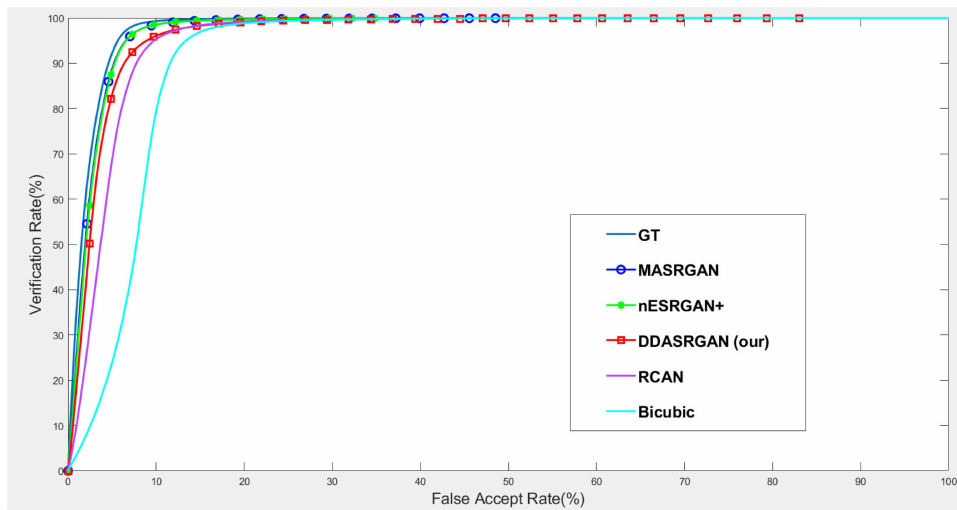
Figure 14. Comparison of ROC curves for each SR model on the CelebA dataset. The figure shows the various SR methods, and the deep-learning-based approaches show the outstanding performance compared to the traditional method (bicubic). The proposed DDA-SRGAN achieves an acceptable performance among all of the deep-learning approaches without the need for prior knowledge of